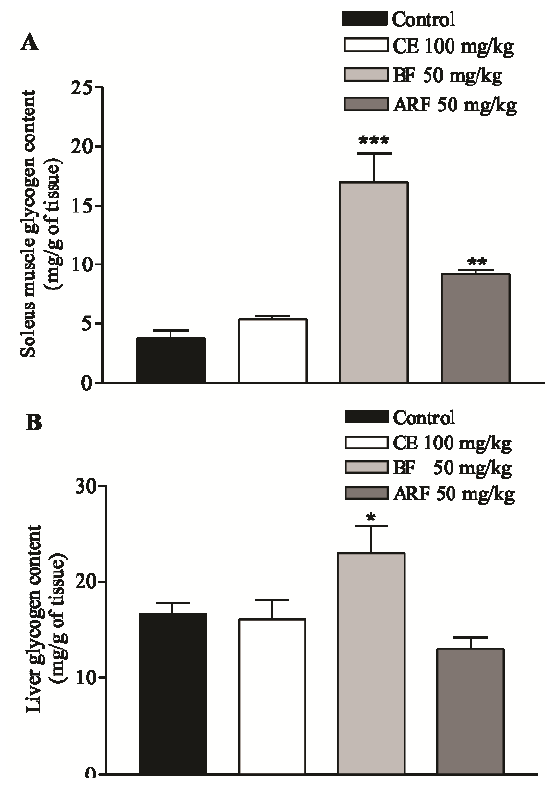
Figure 1. Effect of crude extract (CE), n -butanol fraction (BF) and aqueous residual fraction (ARF) of B. articulata on glycogen content in comparison to hyperglycemic rats (control). ( A ) soleus muscle and ( B ) liver 3 h after treatment by oral gavage. Values are expressed as mean  S.E.M; n = 6 in duplicate for each group. Significantly different to